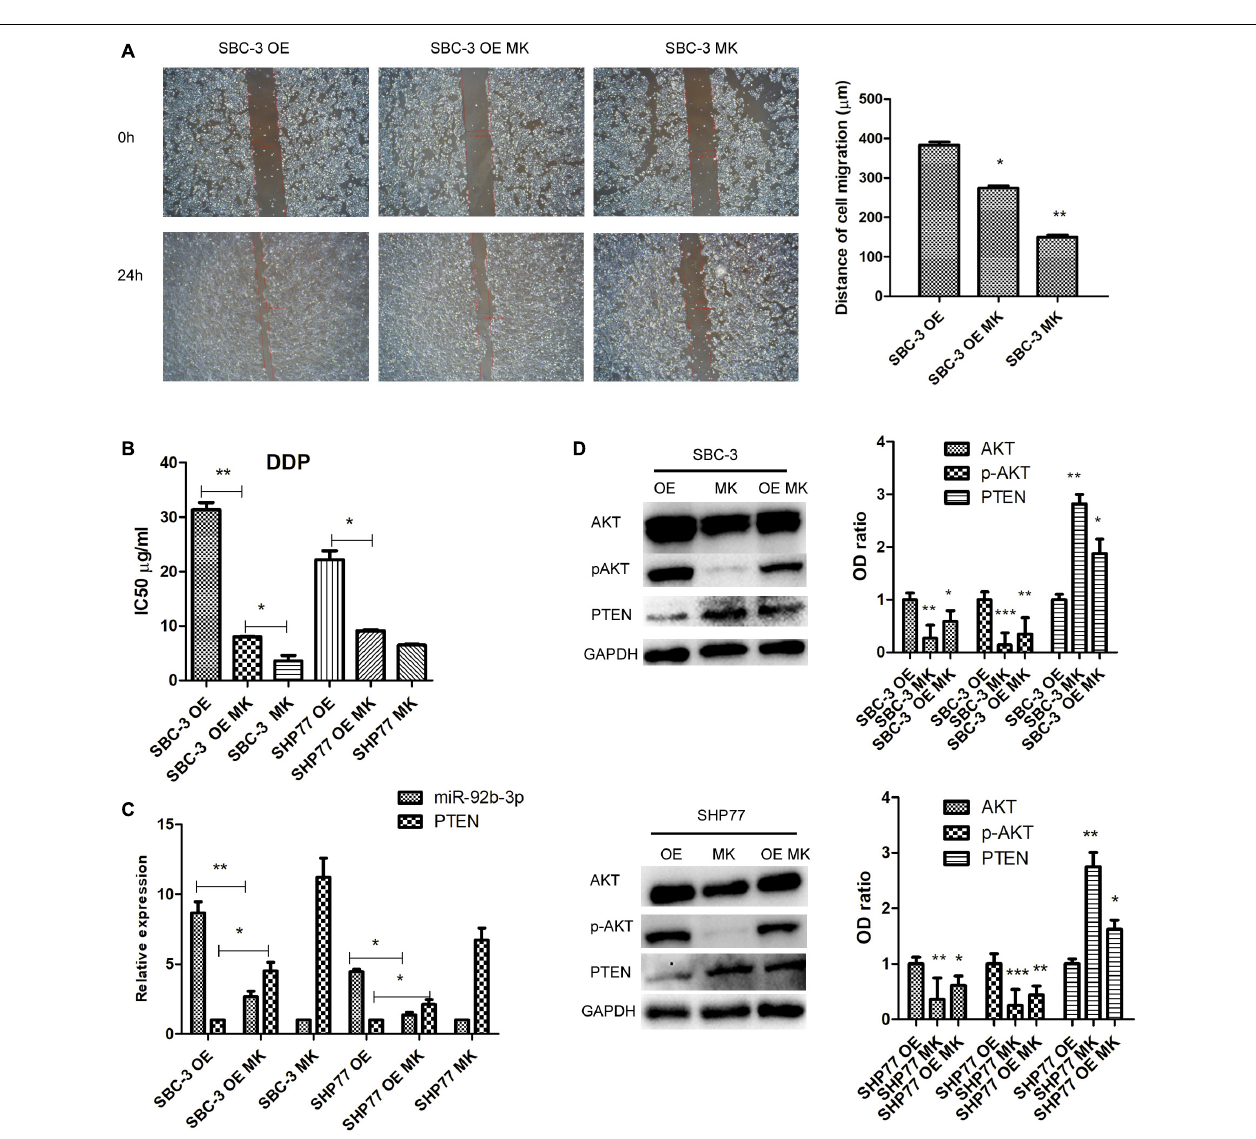
FIGURE 4 | p-AKT downregulation inhibited cell migration and chemoresistance of SCLC. (A) p-AKT downregulation inhibited SBC-3 OE and SBC-3 cell migration. (B) p-AKT downregulation decreased the IC50 value of DDP in SBC-3 and SHP77 cells, whereas this decrease was attenuated in SCLC OE cells. (C) MiR-92b-3p and PTEN levels as detected by qRT-PCR. p-AKT downregulation inhibited miR-92b-3p expression and enhanced PTEN levels in SCLC OE cells. (D) AKT, p-AKT, and PTEN levels as detected by western blot. p-AKT knockdown reduced p-AKT levels and increased PTEN levels in SCLC cells, but this was reversed by miR-92b-3p overexpression. All analyses were performed in triplicate. SCLC, small cell lung cancer and DDP, cisplatin. * P < 0.05, ** P < 0.01, *** P < 0.001.